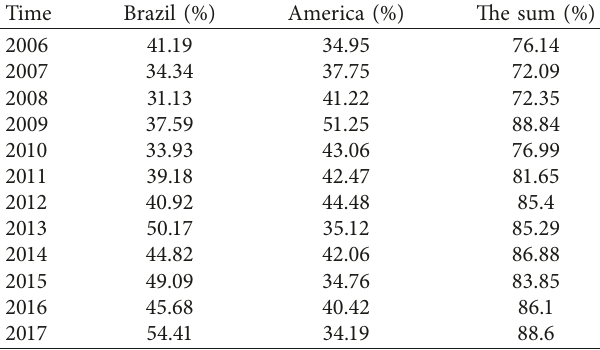
Table 1: China’s share of soybean imports from Brazil and the United States in